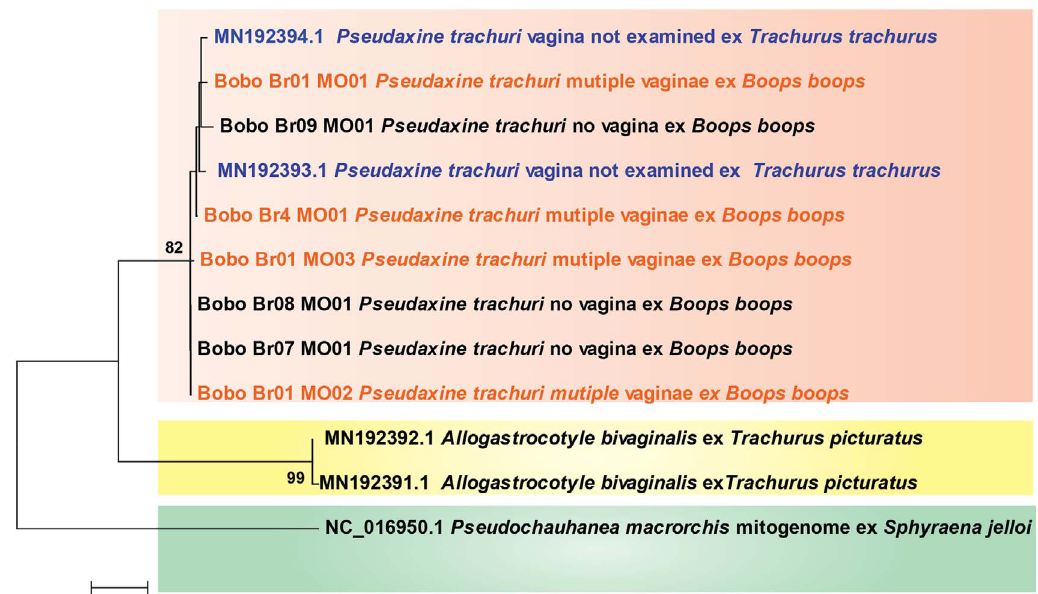
Figure 1. Molecular phylogenetic analysis of monogenean COI sequences using the Maximum Likelihood method. Bootstraps percentages (1000 replicates) are indicated next to the branches when higher than 70. There were a total of 389 positions in the fi nal dataset. The Neighbour-Joining tree had a similar topology and is not represented. All specimens of Pseudaxine trachuri , whether with no vagina or with “ multiple vaginae ” , and whether from the type-host Trachurus trachurus or from Boops boops , were grouped into a single monophylum and showed little variation